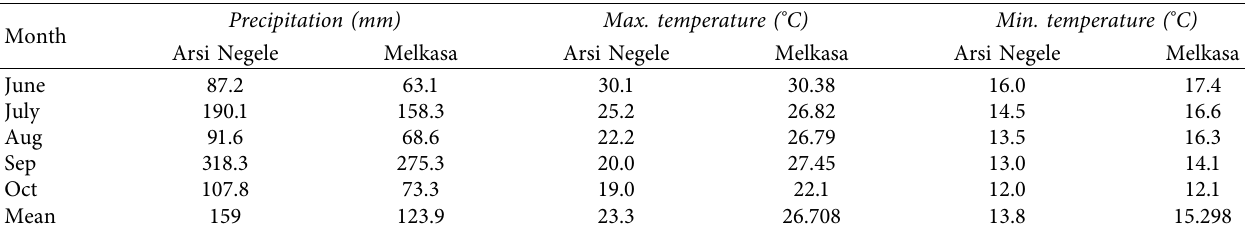
Figure 1: Administrative map of the study sites (Google Map: ARC GIS, Table 1: Mean monthly temperature and rainfall of experimental sites during 2019 cropping season.